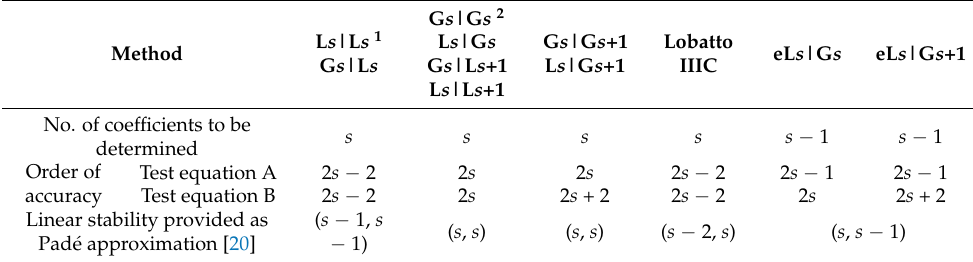
Table 2. The accuracy orders of the proposed methods, Lobatto IIIA, Lobatto IIIC [22], and Gauss– Legendre [21] methods when applied to the test equations in Equation (20). Linear stability (integrat- ing test equation A in Equation (20)) is reported in the form of Pad é approximation [20].